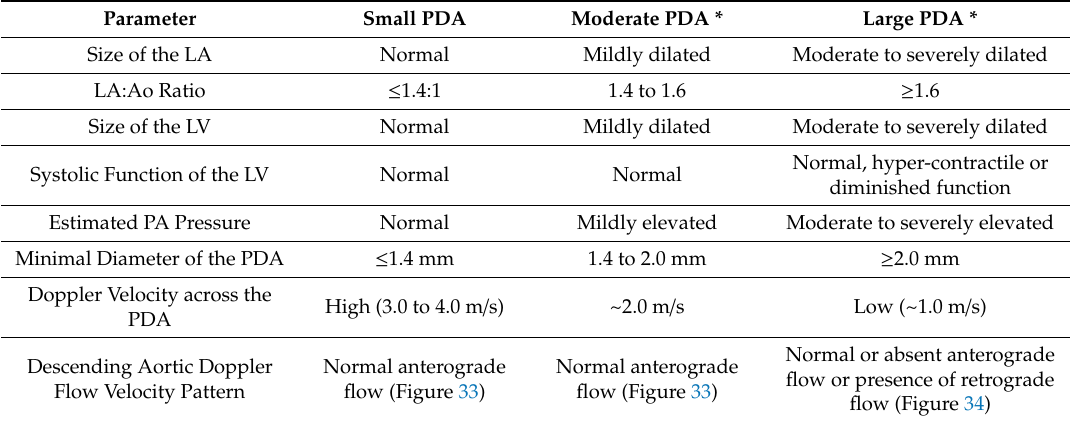
Table 2. Characterization size of Patent Ductus Arteriosus (PDA) in premature infants by echo-Doppler studies.